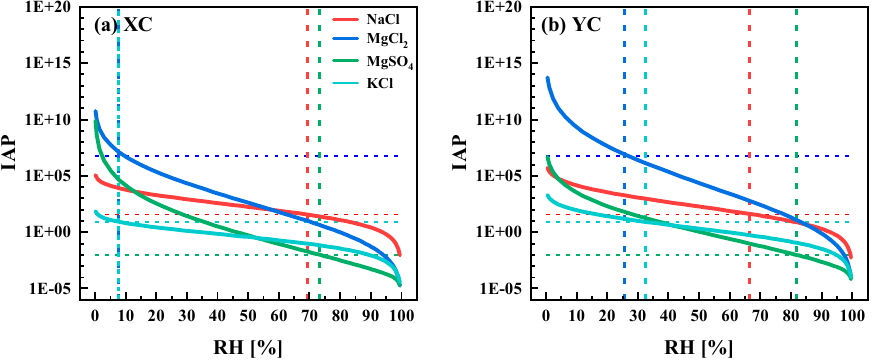
Figure 2. IAP as a function of RH, including four salt components in two brine samples.